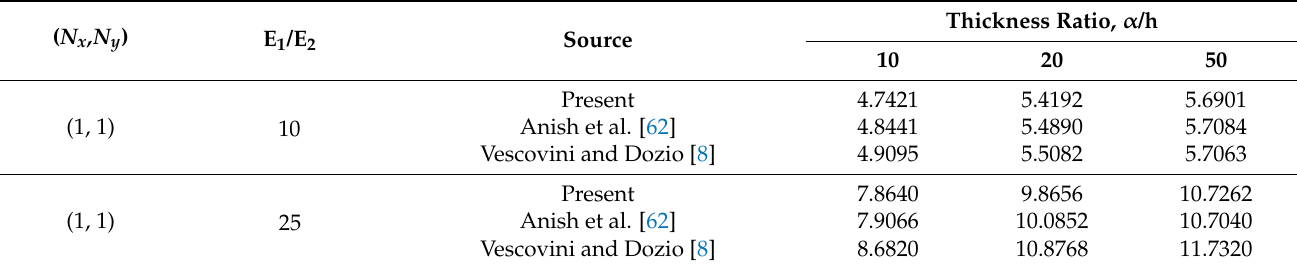
Table 5. Comparison of nondimensional buckling loads, N = N cr α 2 / E 2 h 3 , for simply supported cross-ply